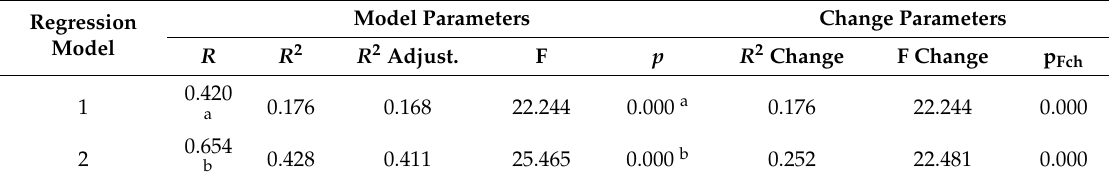
Table 2. Parameters of the hierarchical regression models (model 1 and model 2).